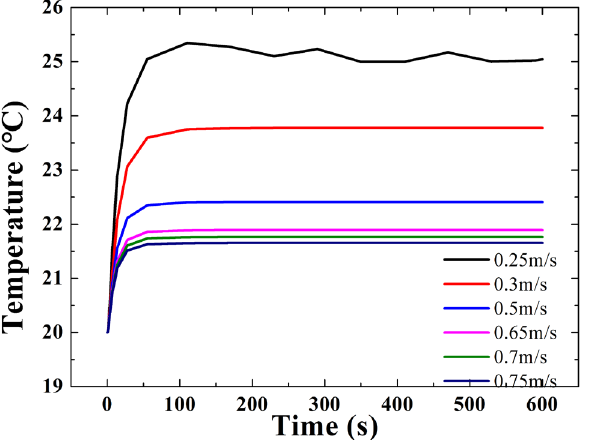
Figure 8. Temperatures of the Terfenol-D rod vs. the flow velocity of silicone oil.